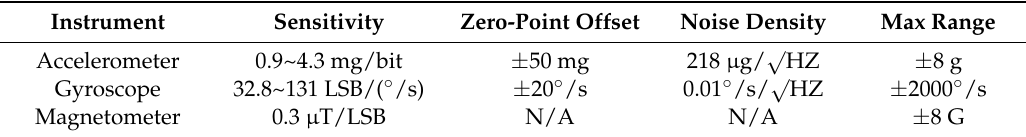
Figure 7. UWB tag and IMU. Table 1. Key specifications of the IMU.